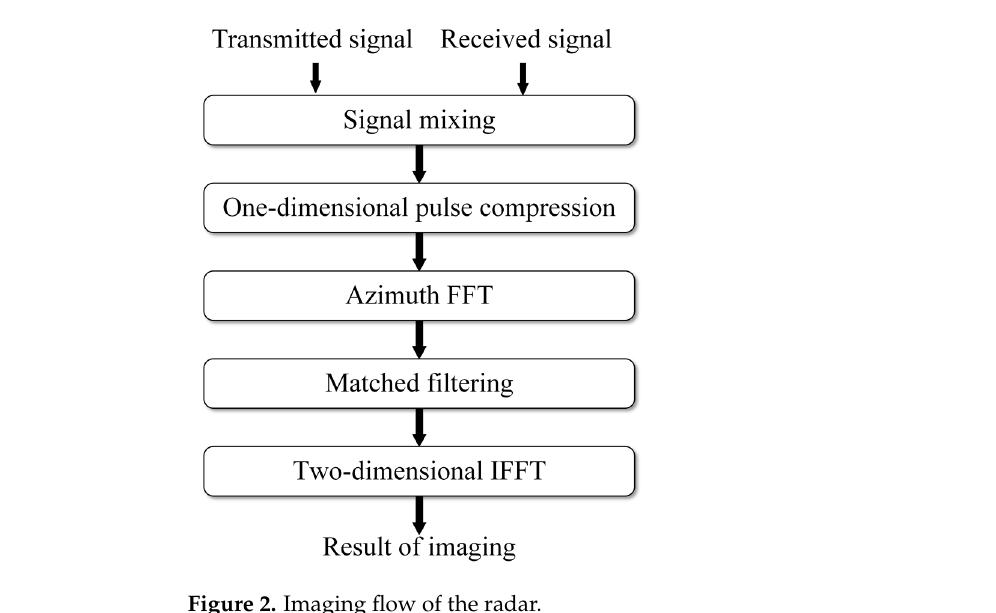
Figure 3. The classical detection flow of SAR images.